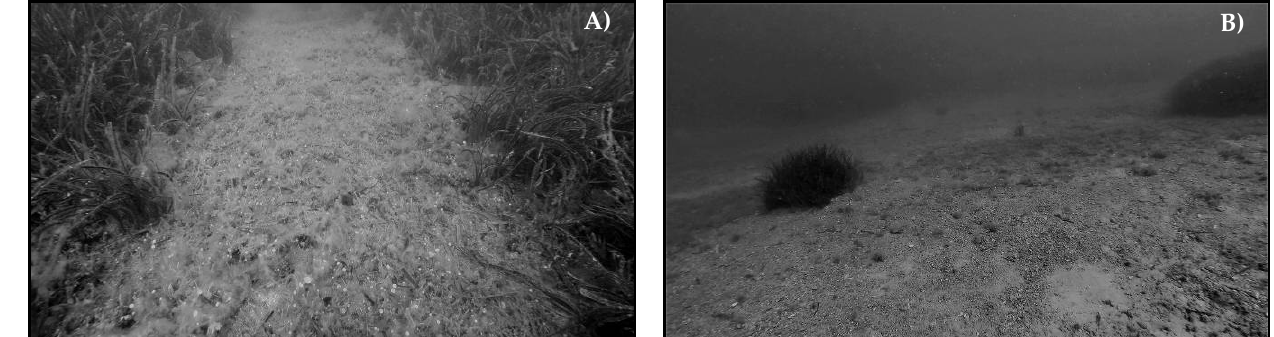
Figure 2. Degraded areas at Capo Carbonara ( A ) and Elba Island ( B ).